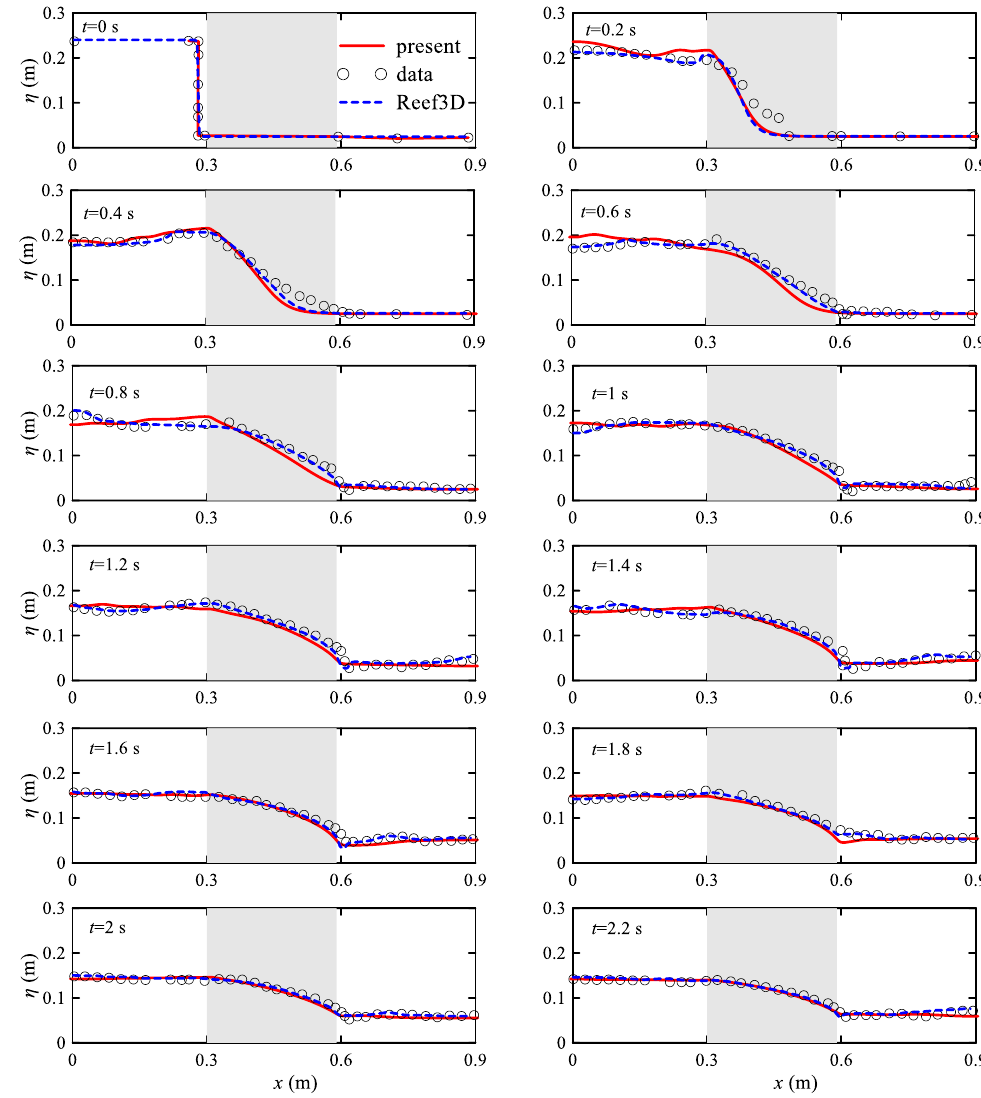
Figure 3. Comparison of water level from the BT model simulation, experimental data and REEF3D simulation [4] (dashed line).